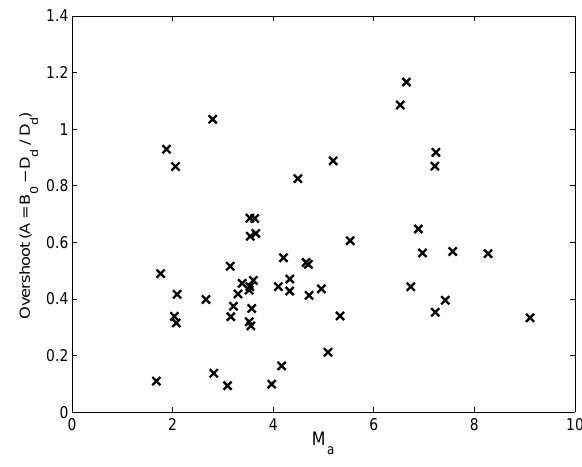
− B d Fig. 4. Overshoot ( A = B o ) plotted against the Alfv´en Mach B d